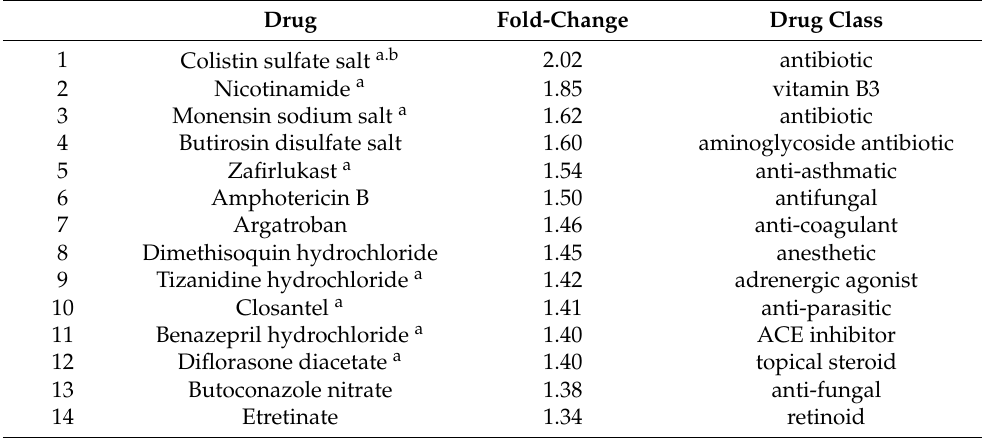
Table 1. Compounds identified as enhancers of NK92 cytotoxicity from screening the Prestwick Chemical Library. Listed drugs had a luminescent fold-change ≥ 1.3 on both screening days. Drug class for each compound is listed. a Candidate drugs that were selected for further investigation. b Fold-change of single screening. Drug